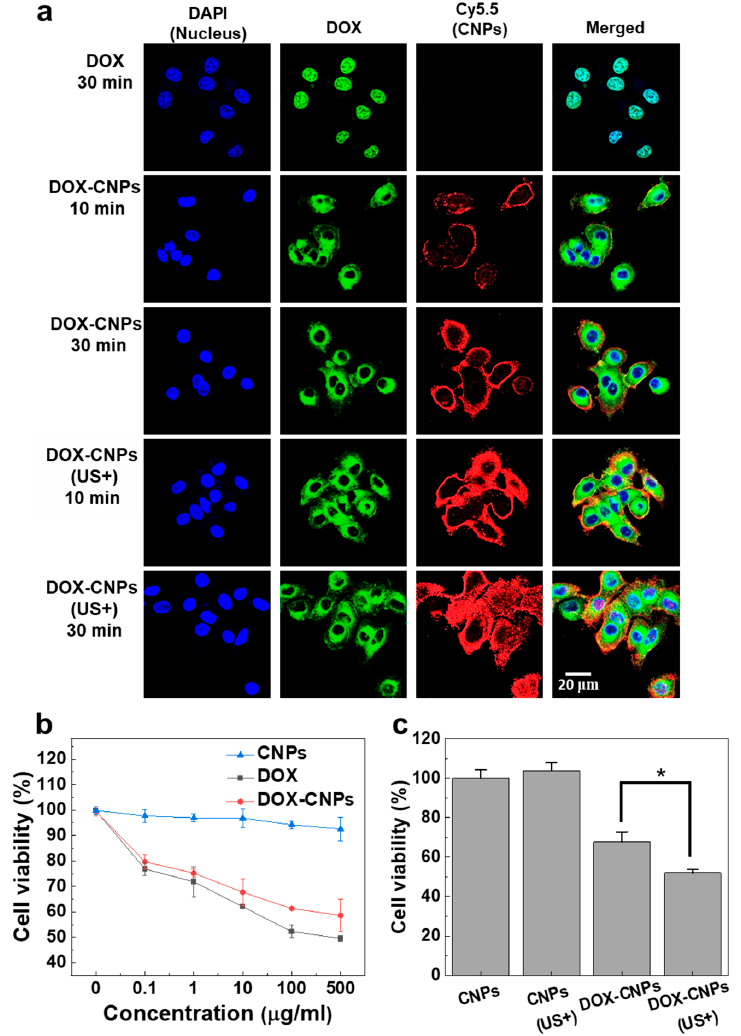
Figure 3. In vitro cellular uptake and cell viability of DOX-CNPs in cultured cells. ( a ) HIFU-triggered (US + ) cellular uptake mechanism of DOX-CNPs. A549 cancer cells were incubated with free DOX (1